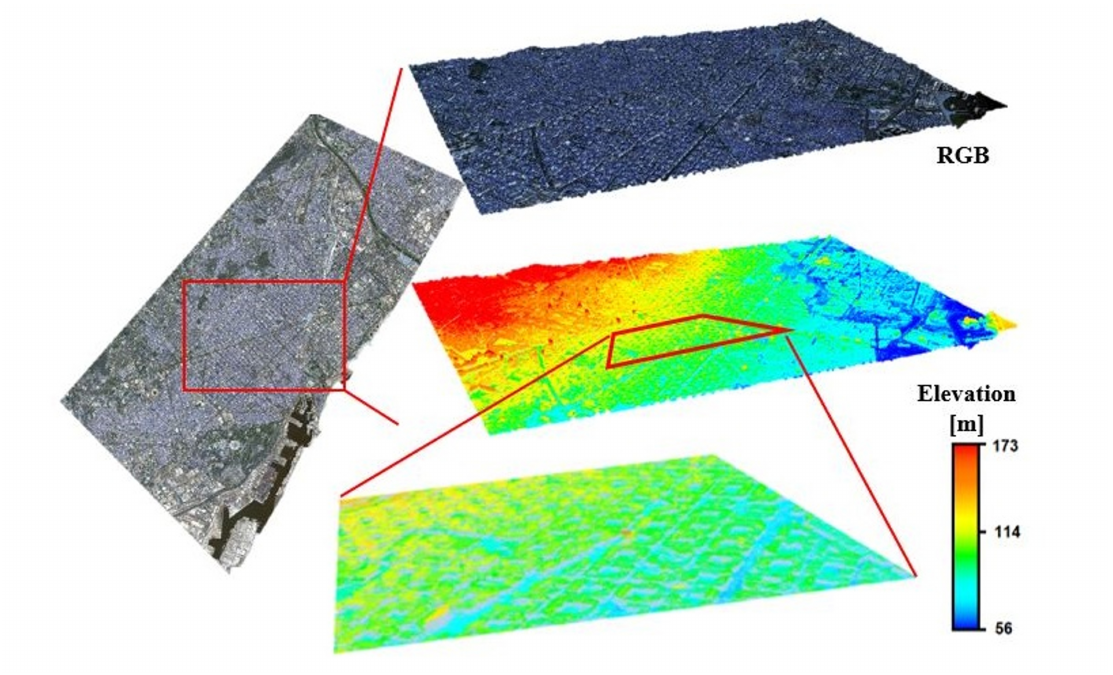
Figure A2. 3D point cloud of Barcelona city colored by RGB and elevation information with a zoom of a selected area in the city center.